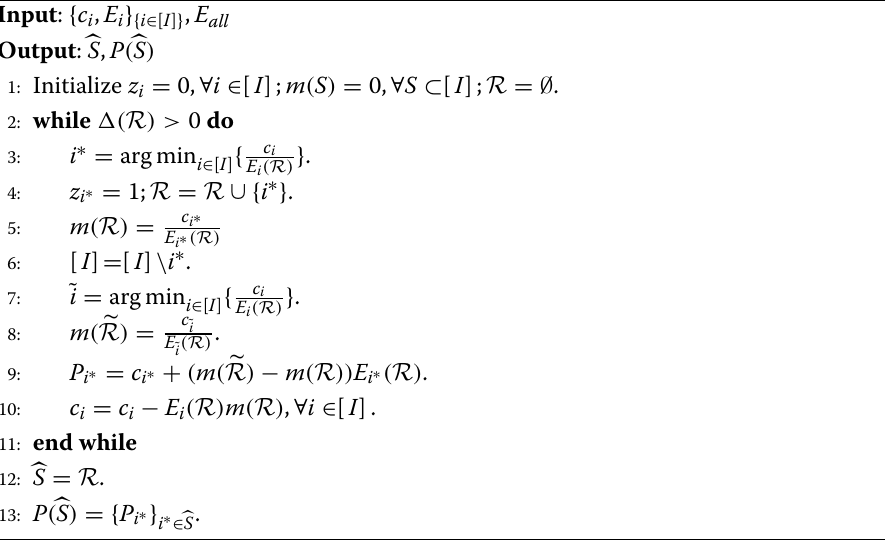
Algorithm 1 A 2-Approximation Auction Mechanism for EDR: